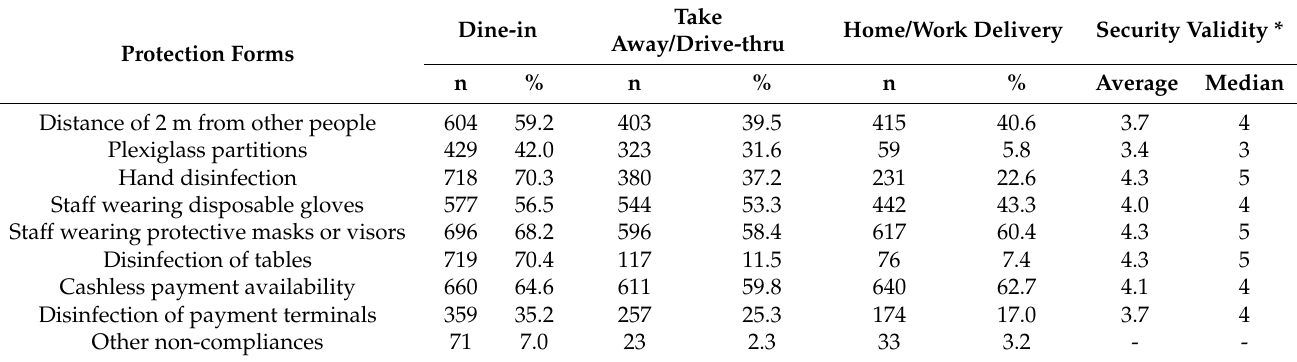
Table 5. Protection used in catering establishments against the spread of the virus